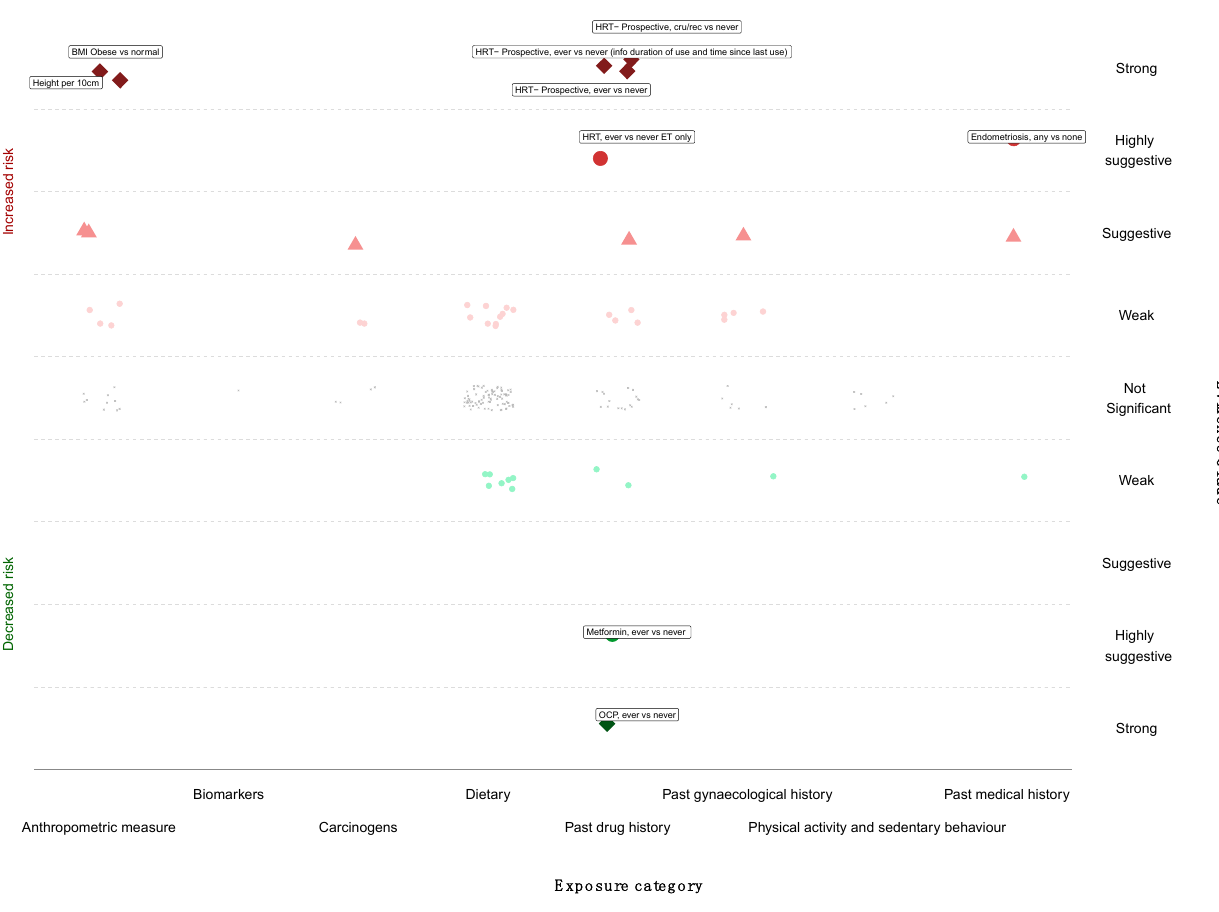
Figure 2. Evidence grading results of the main analysis (cohorts only, random summary effects) displaying the association with increased or decreased risk of ovarian cancer by risk category.